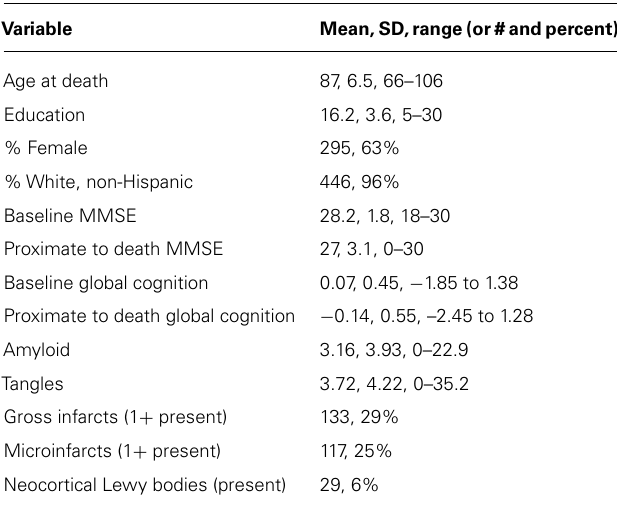
Table 1 | Descriptive characteristics of the